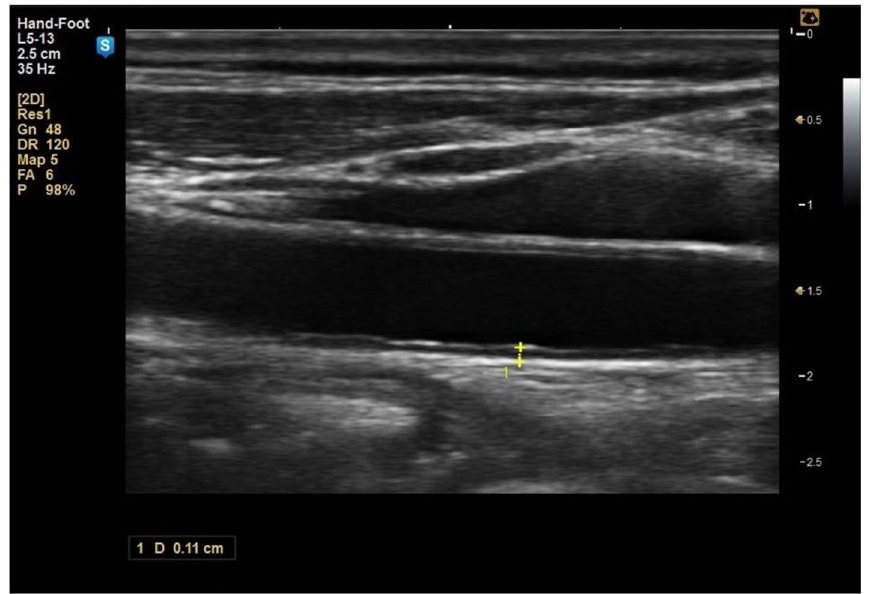
Fig. 1 Carotid IMT in PsA patient